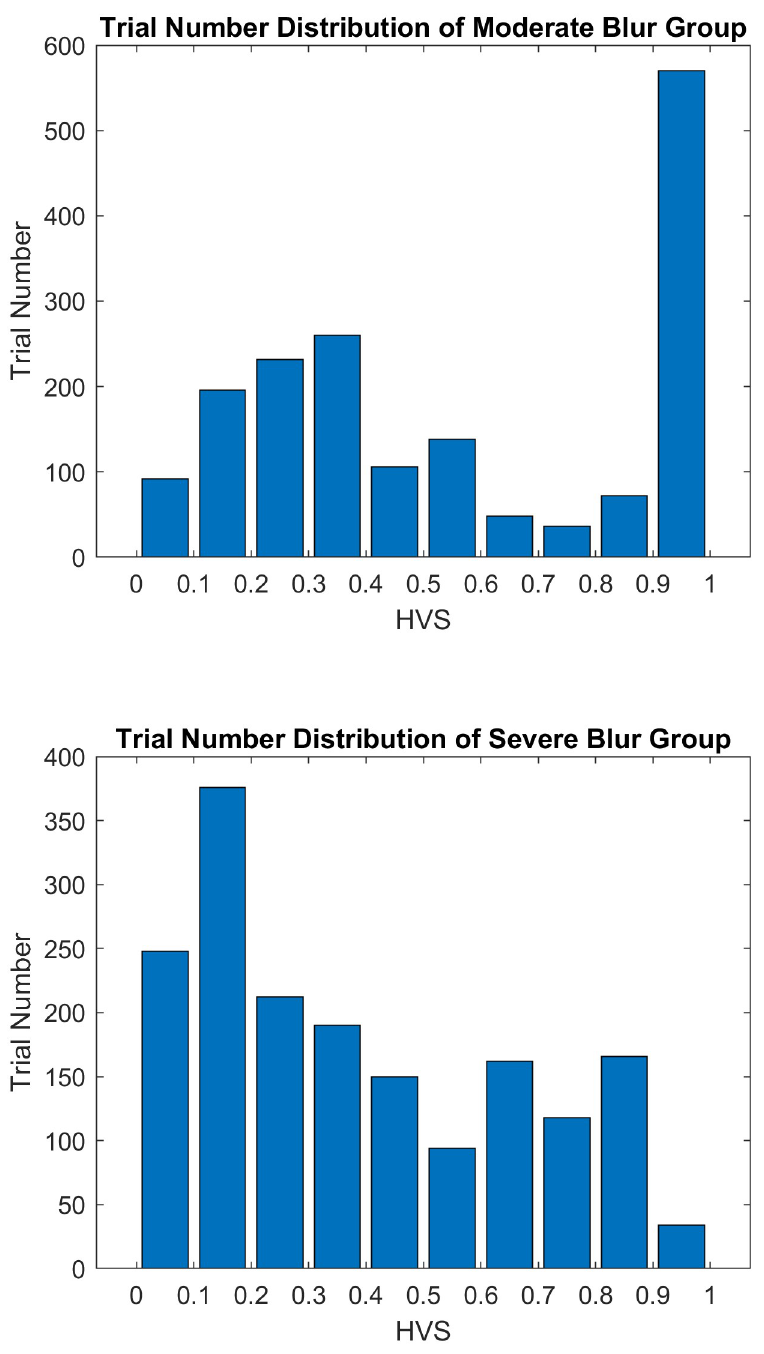
Fig 3. Distribution of trials in ten HVS bins, each covering 0.1 width in a zero to one range. The upper panel shows the trial distribution for Moderate blur (1.2 logMAR) and the lower panel shows the distribution for Severe blur (1.6